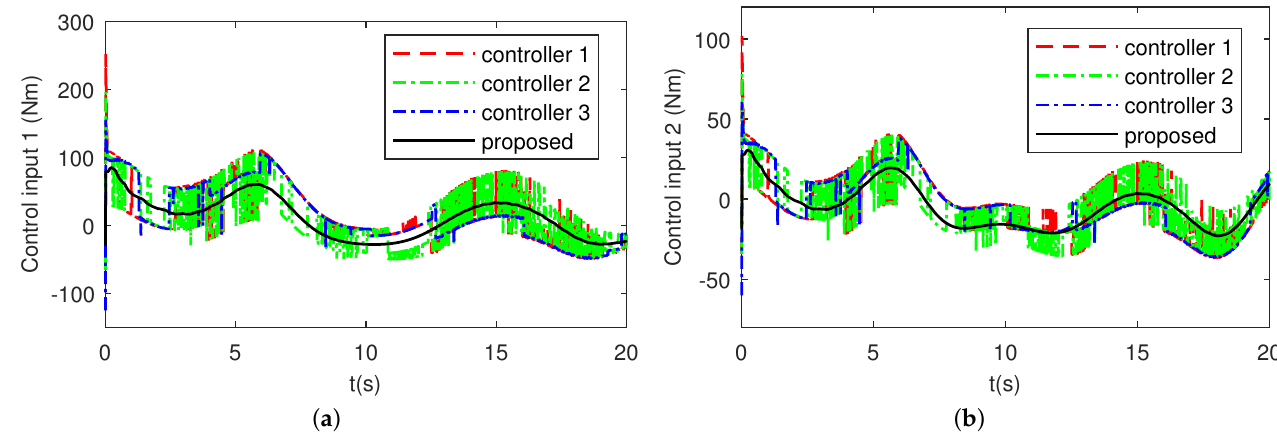
Figure 4. Control inputs with disturbances: ( a ) Link 1. ( b ) Link 2.